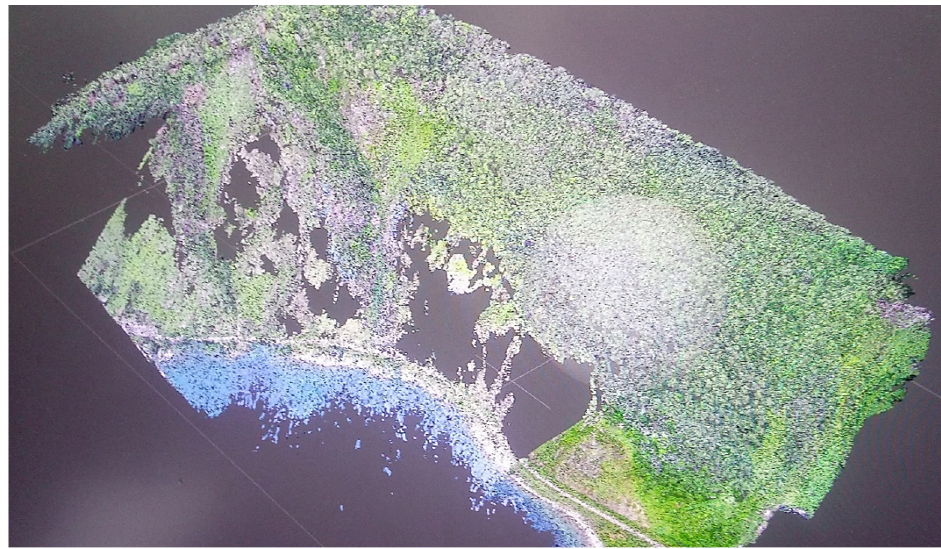
Figure 6. Terrain model of the study site derived from the nadir imagery.